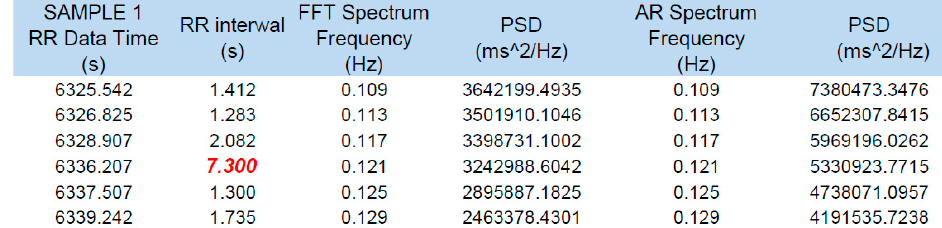
Figure 3. Longest pause recorded exclusively on the HRM through its HRV function, of 7.3 s. (red).